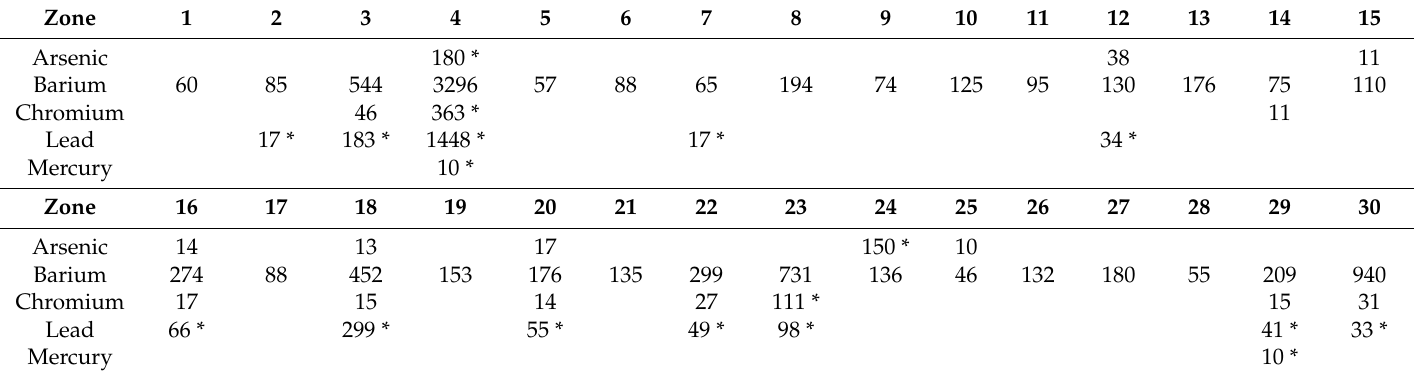
Mercury 10 * * Levels above National Recommended Water Quality Criteria for Chronic Exposure for Aquatic